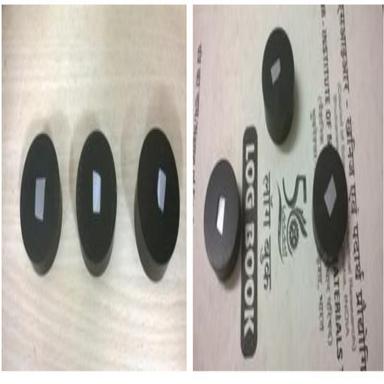
Specimen for hardness testing (a) Rockwell hardness (b) Vicker's hardness.